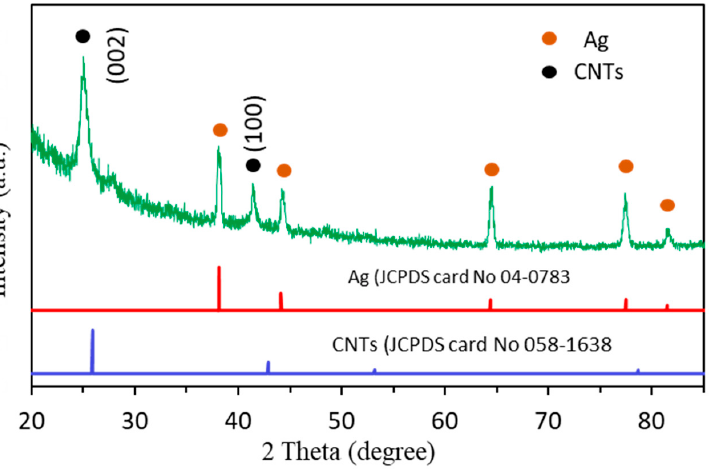
Figure 2. XRD diffractogram of the fabricated CNT-Ag electrode. The red and blue lines represent the standard JCPDS data of Ag and CNTs, respectively.